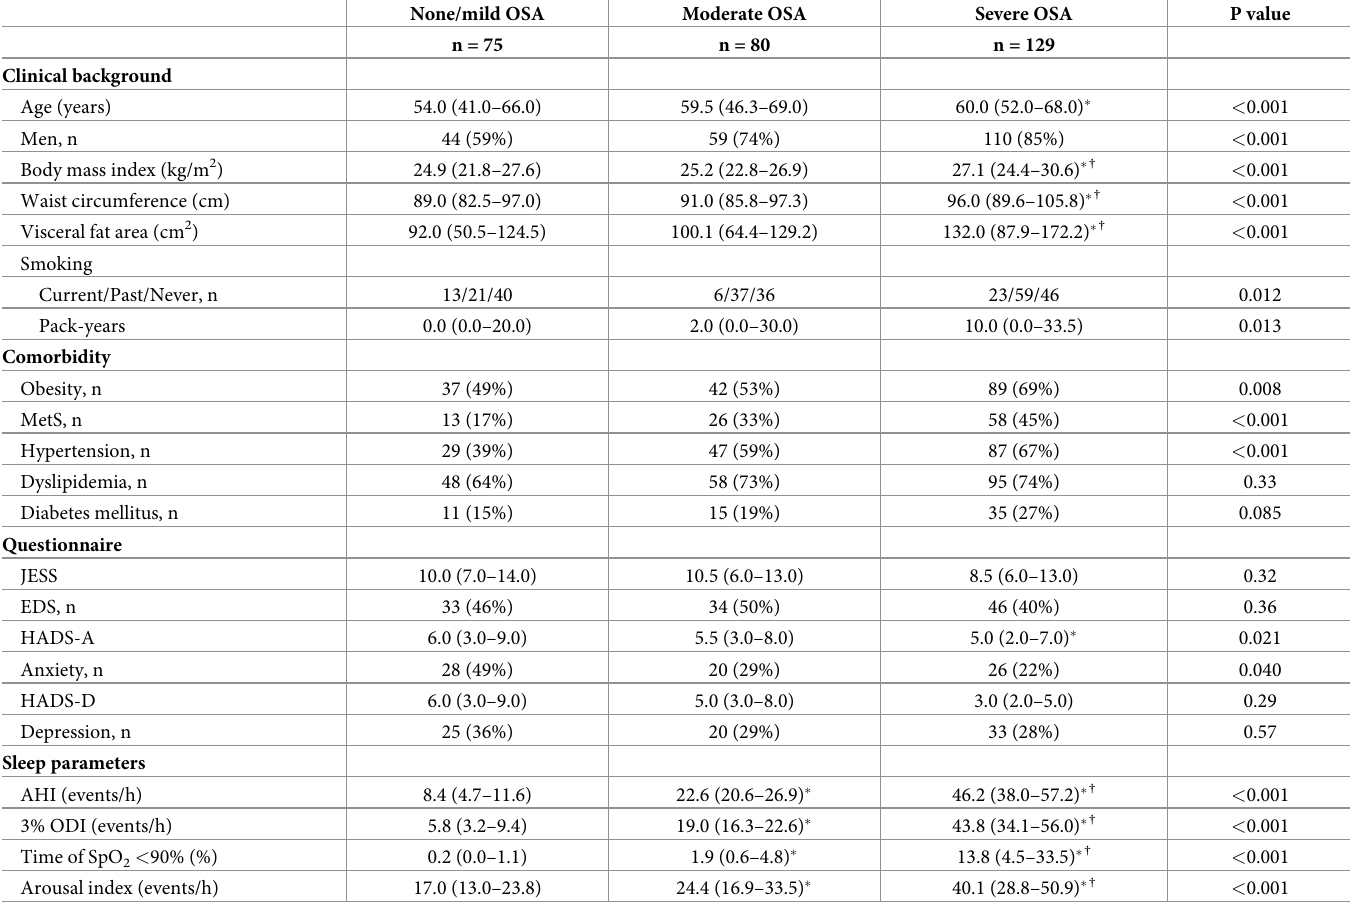
Table 1. Characteristics of study participants according to OSA severity. None/mild OSA Moderate OSA Severe